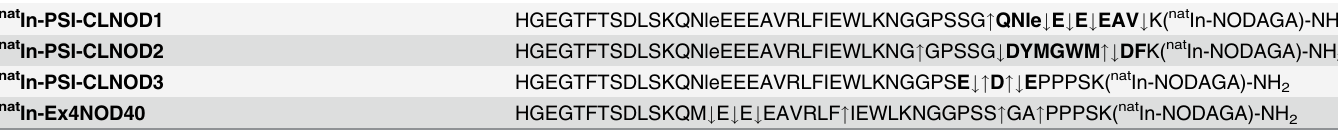
Table 2. Cleavage sites of In-labelled peptides digested with meprin α and β .